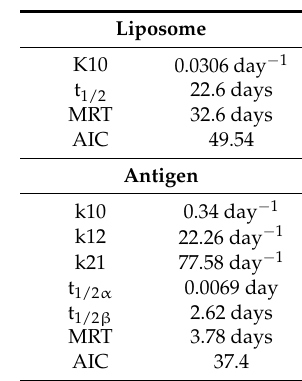
Figure 4. A bi-exponential model of in-vitro antigen stability. Table 2. Summary of model-fitted pharmacokinetic parameters.